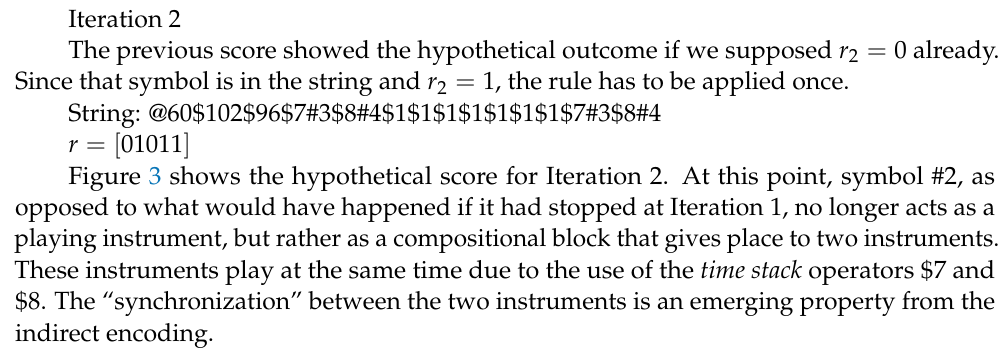
Figure 2. Resulting score from Iteration 1 (Audio S2).